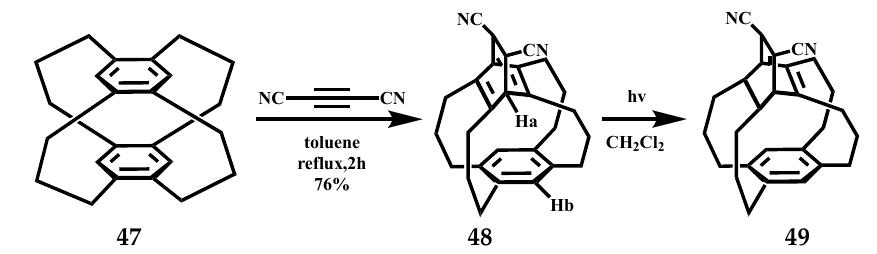
Figure 21. The cycloaddition and photoirradiation of [3 4 ](1,2,4,5)CP 47 .